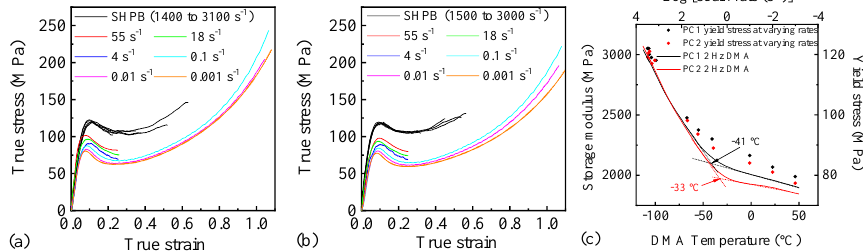
Fig. 3. (a) PC1 stress-strain curve at varying rates and room temperature, (b) PC2 stress-strain curve varying rates and room temperature, (c) Rate-dependent yield stress and 2 Hz DMA result comparison for PC1 and